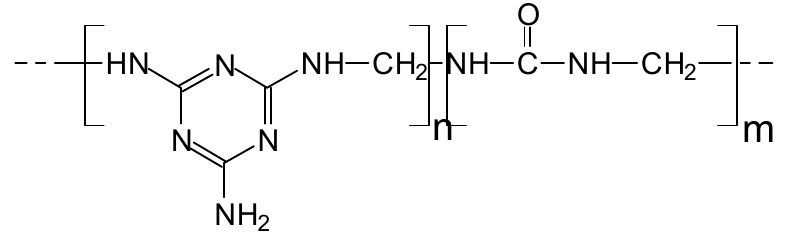
Scheme 2. Schematic representation of a MUF resin.